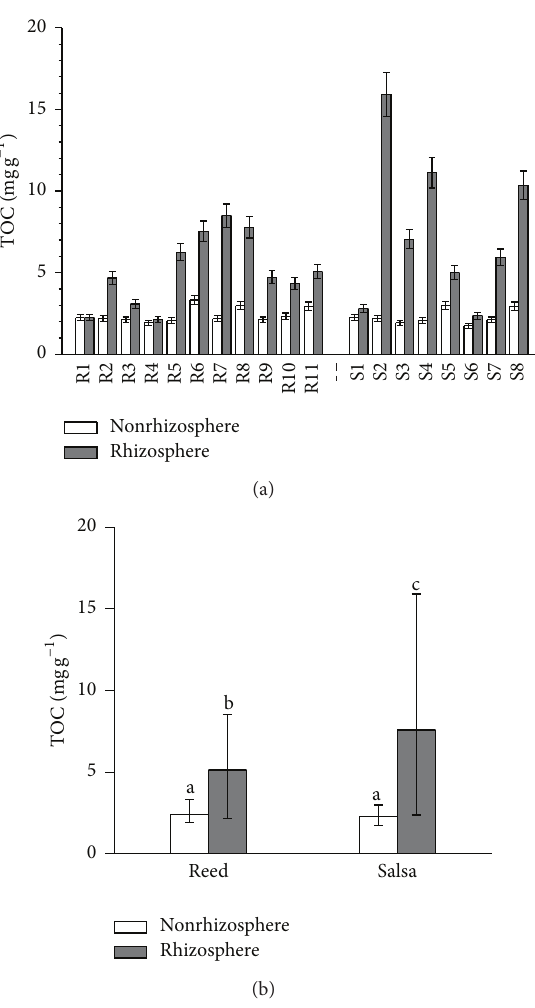
Figure 6: TOC contents in rhizosphere and nonrhizosphere soils of reed and salsa. The columns represent the average contents and the error bars in left part represent the uncertainty U of TOC contents and in the right part represent the variation range. The